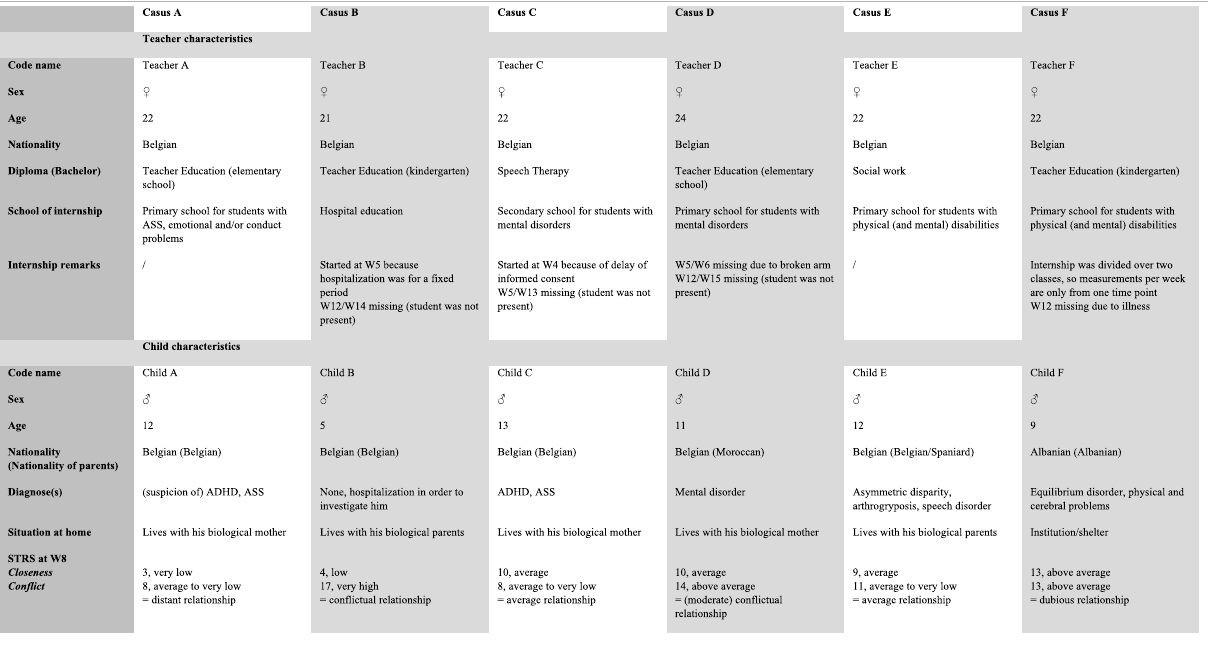
TABLE 1 | Overview of detailed information of each teacher and target